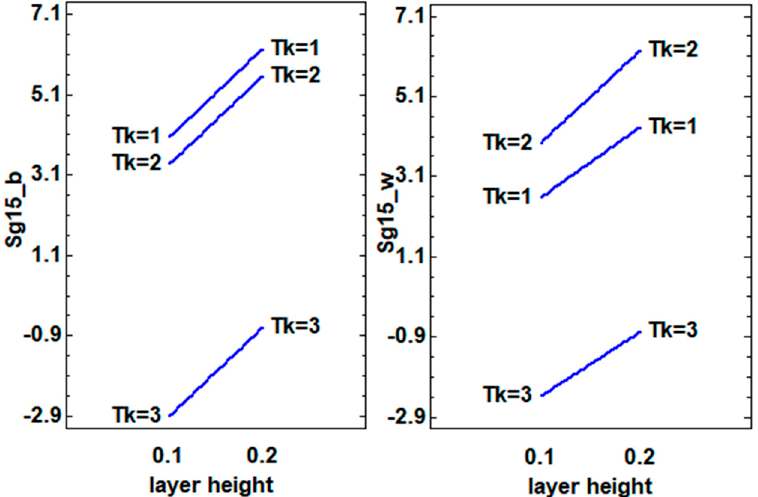
Figure 5. Schematic of the hypothetical orientation of the flakes: left in the sample thickness 0.5 mm (Tk = 1) and layer height (Lh) 0.1 mm, right sample thickness 0.8 mm (Tk = 2) and layer height (Lh) 0.2 mm.